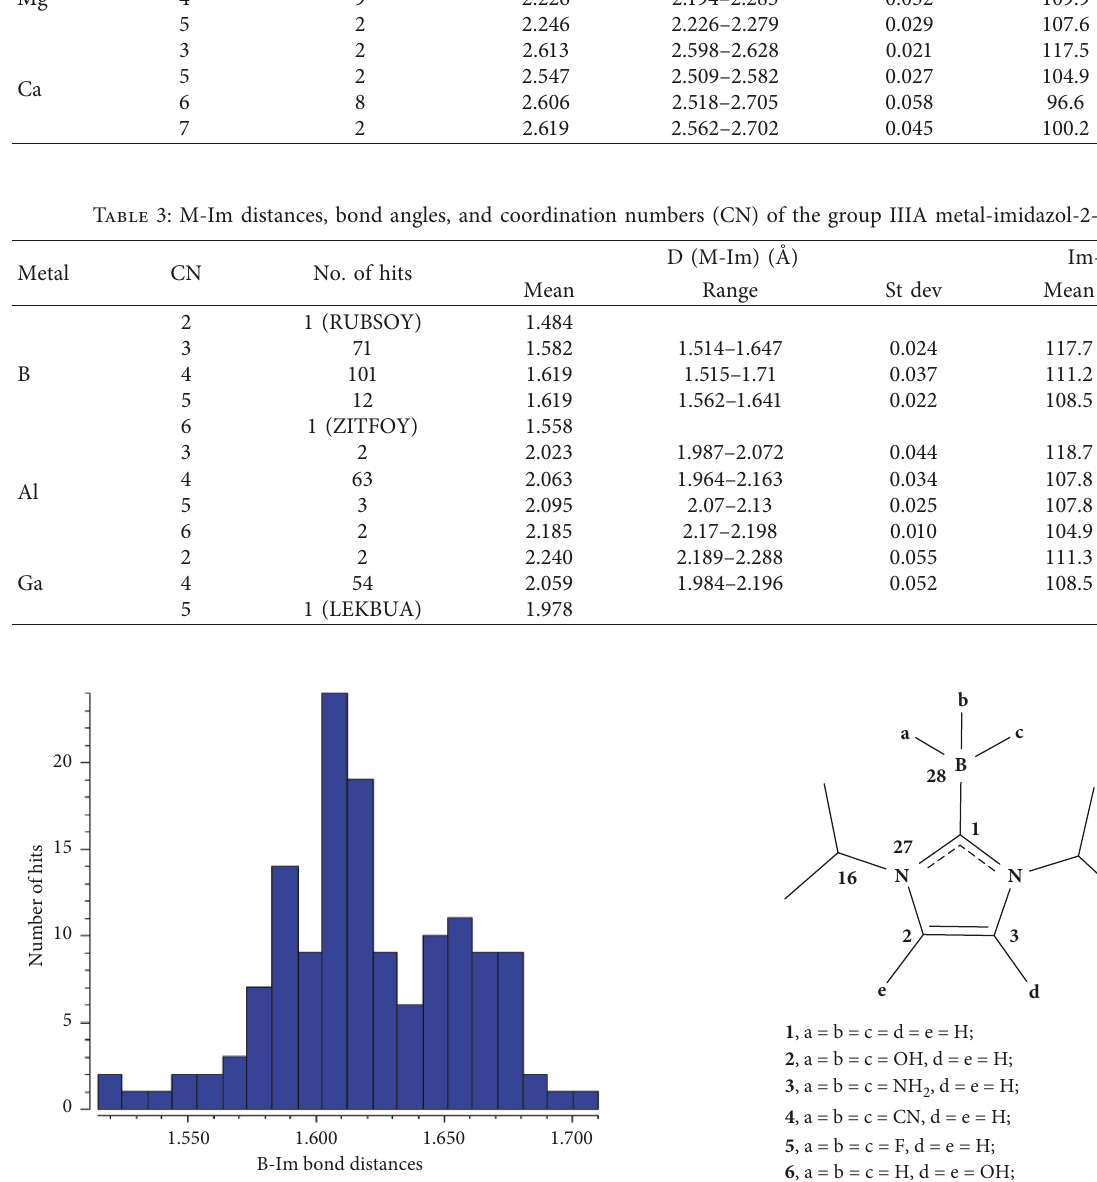
Figure 2: Distribution of B-Im bond lengths in tetrahedral boron imidazol-2-ylidenes.